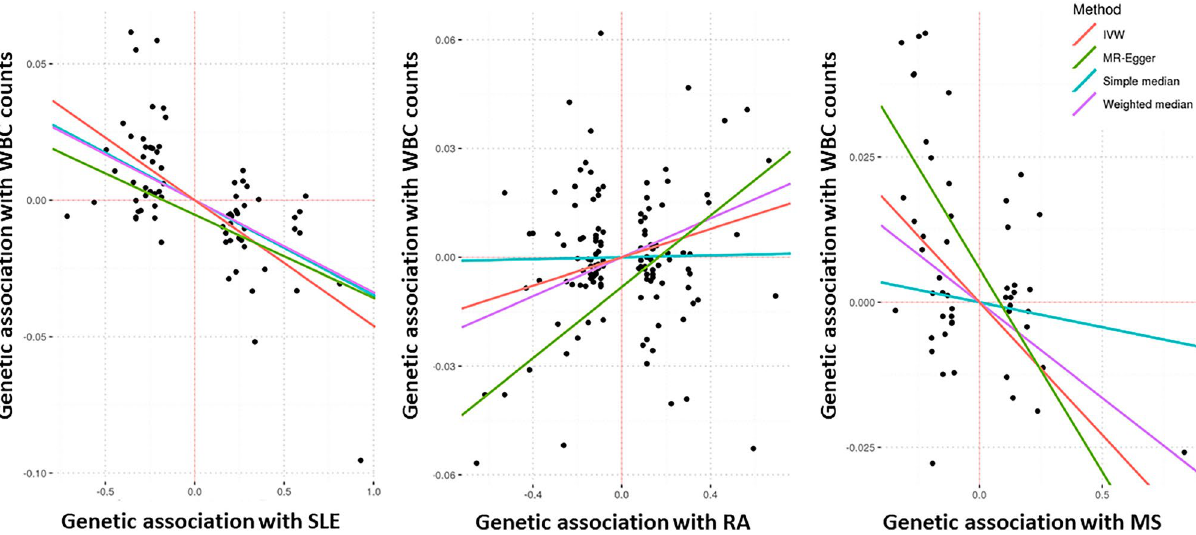
Figure 2. Scatter plots of the inverse-variance weighted regression for systemic lupus erythematosus (SLE), rheumatoid arthritis (RA), and multiple sclerosis (MS) with WBC counts (log transformed). X axes represent the log-odds of the genetic instruments on disease risk (SLE, RA, and MS); and Y axes represent the effect of the genetic instruments in transformed white blood cell (WBC) counts. IVW inverse-variance weighted regression.